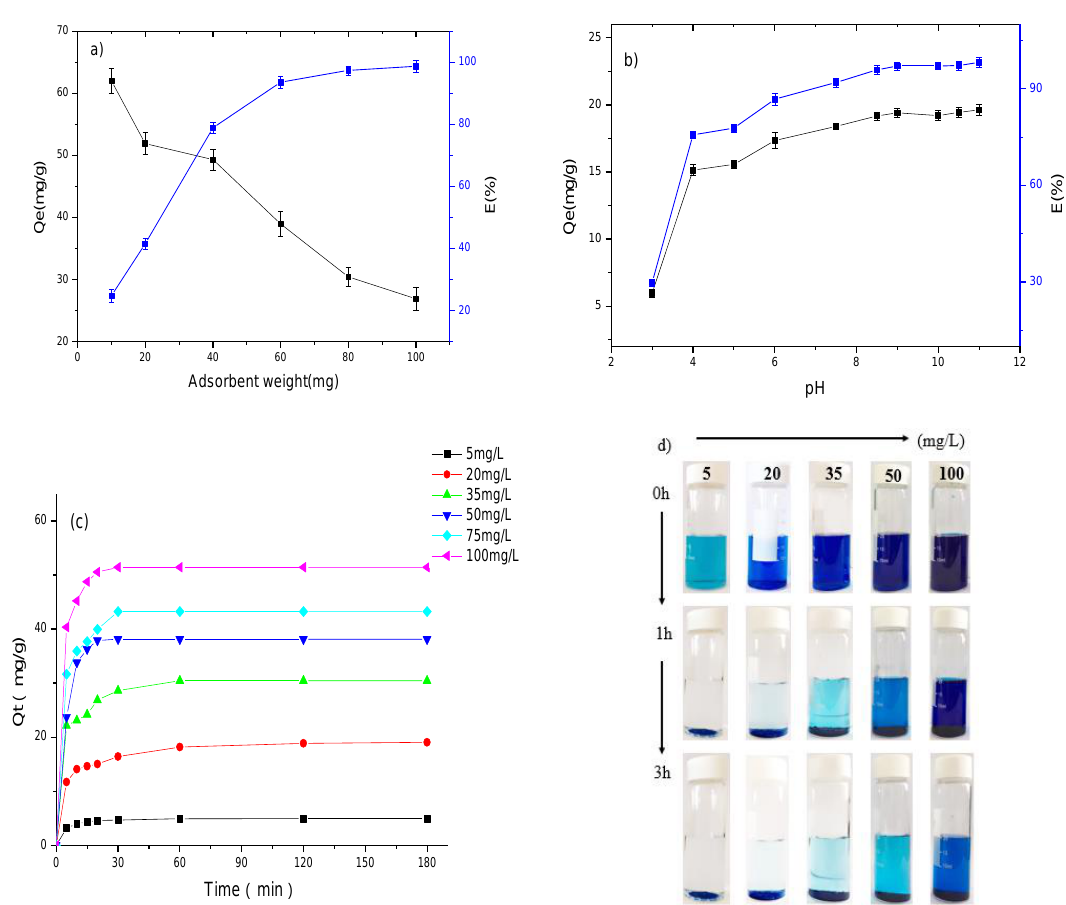
Figure 6. ( a ) Effective dosage of 6-EA-β-CD-Si on adsorption capacity of MB; ( b ) Effect of pH on adsorption of methylene blue (MB) by 6-EA-β-CD-Si; ( c , d ) MB solutions adsorbed by 6-EA-β-CD-Si at different incubation time.